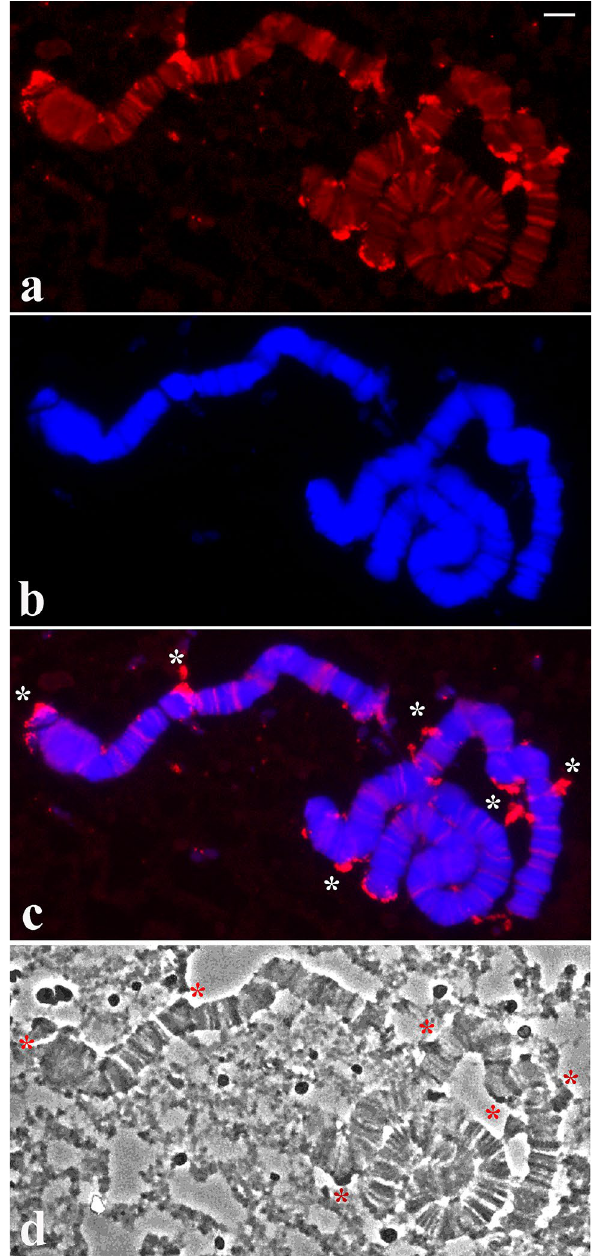
Figure 4. ( a–d ) Transcriptional activity in Schwenkfeldina sp. polytene chromosomes as visualised by the detection of endogenous RNA.DNA hybrids. Fluorescent antibody signals ( a ), the corresponding DAPI image ( b ), the merged signals ( c ) and the same chromosomes under phase contrast ( d ) The asterisks point to some examples in which fluorescent detection of endogenous hybrids is seen in micronucleolar bodies either disconnected or attached to the chromosomes. Bar = 15